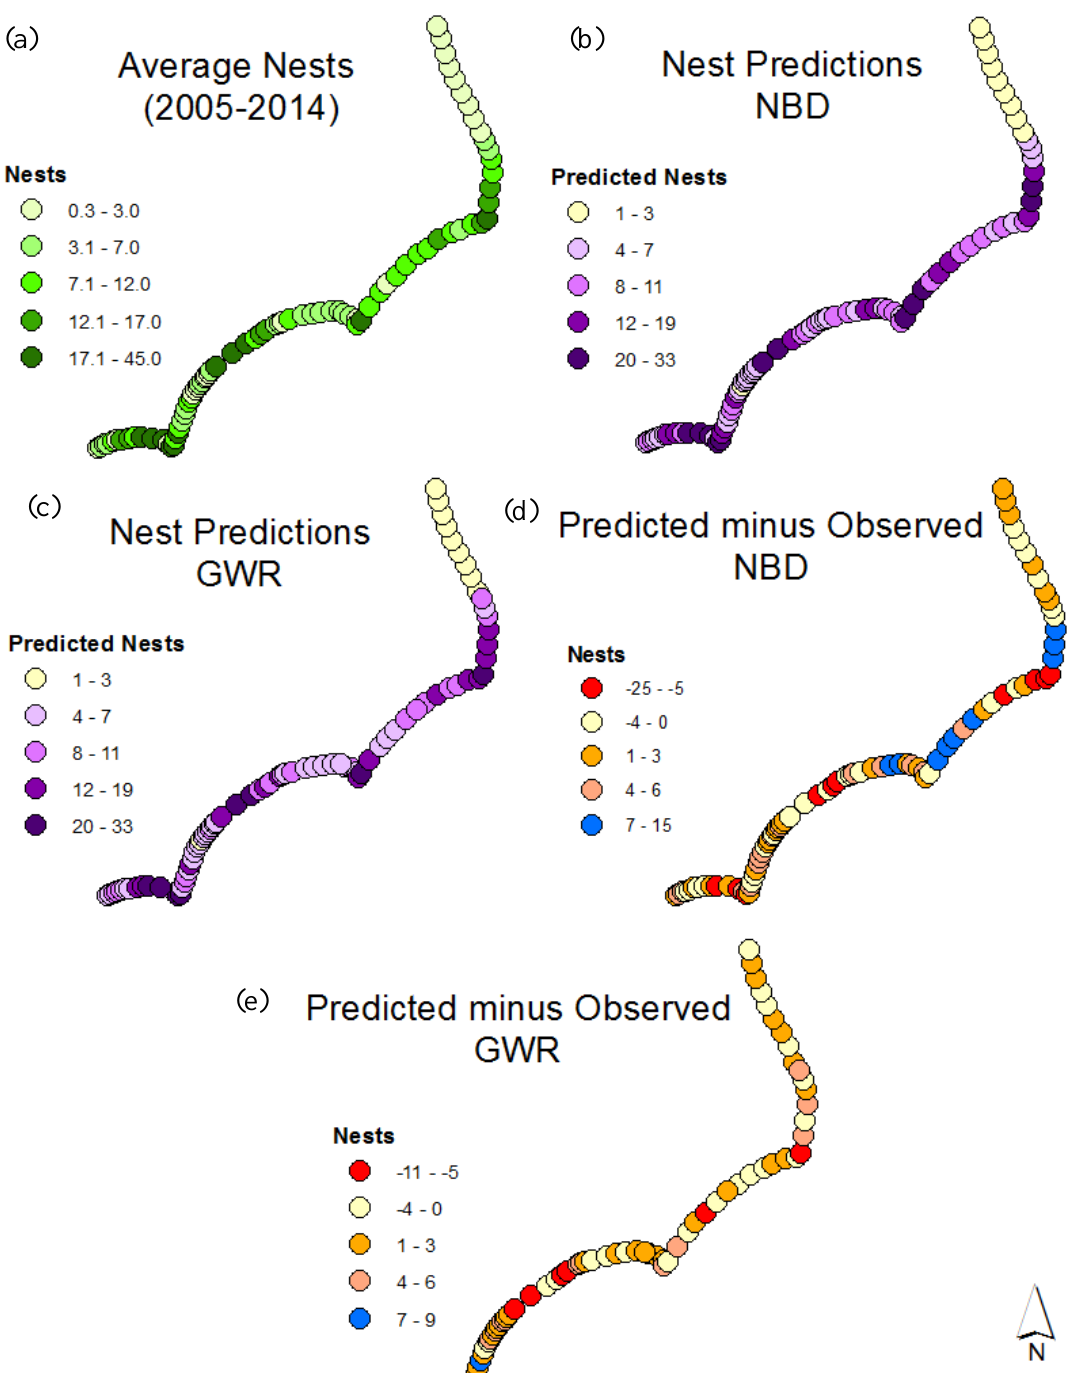
Figure 7. Negative Binomial Distribution and Geographically Weighted Regression models for all nesting years (2005–2014): ( a ) average number of nests (by transect), ( b ) predicted number of Negative Binomial Distribution (NBD), ( c ) predicted number of nests using Geographically Weighted Regression (GWR), ( d ) predicted nests (NBD) minus observed (average number of nests), and ( e ) predicted nests (GWR) minus observed (average number of nests). Nesting predictions were better using GWR in comparison to NBD.